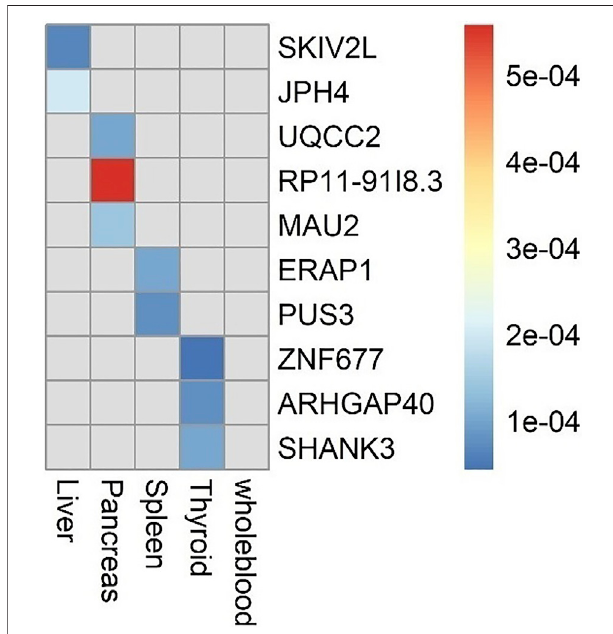
FIGURE 2 | Genes signi fi cantly associated with risk of cirrhosis in each